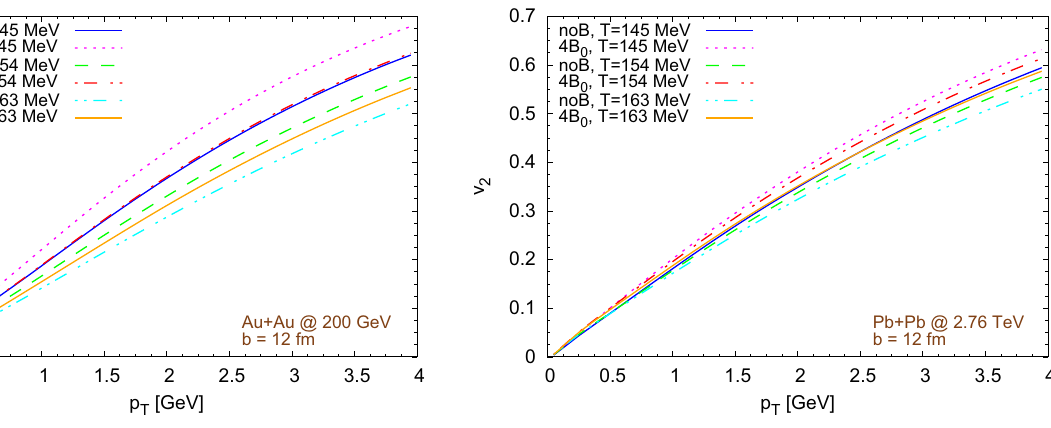
Fig. 19 Ellipticflowatmid-rapidityvstransversemomentum.Theleft to have an initial magnetic field 4 times larger than our estimates. We √ s NN = 200GeV, the right fig- figure refers to Au+Au collisions at explore the effect of different freeze-out temperatures. We notice how √ s NN = 2 . 76TeV. In both cases, we ure refers to Pb+Pb collisions at the presence of a magnetic field always enhances the elliptic flow com- run simulations with a fixed impact parameter b = 12fm. We assume pared to the pure hydro